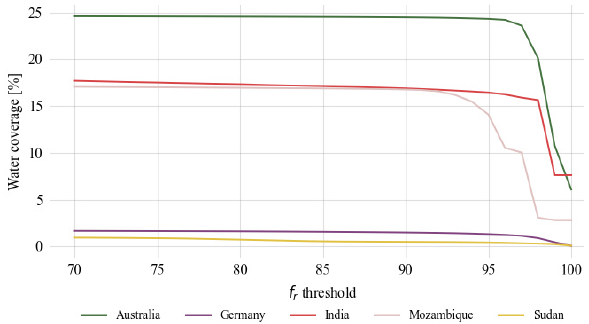
Figure 2 . Sensitivity analysis for the definition of the threshold value of the relative water frequency f r within the range 70- 100% for the five test areas in Australia, Germany, India, Mozambique, and